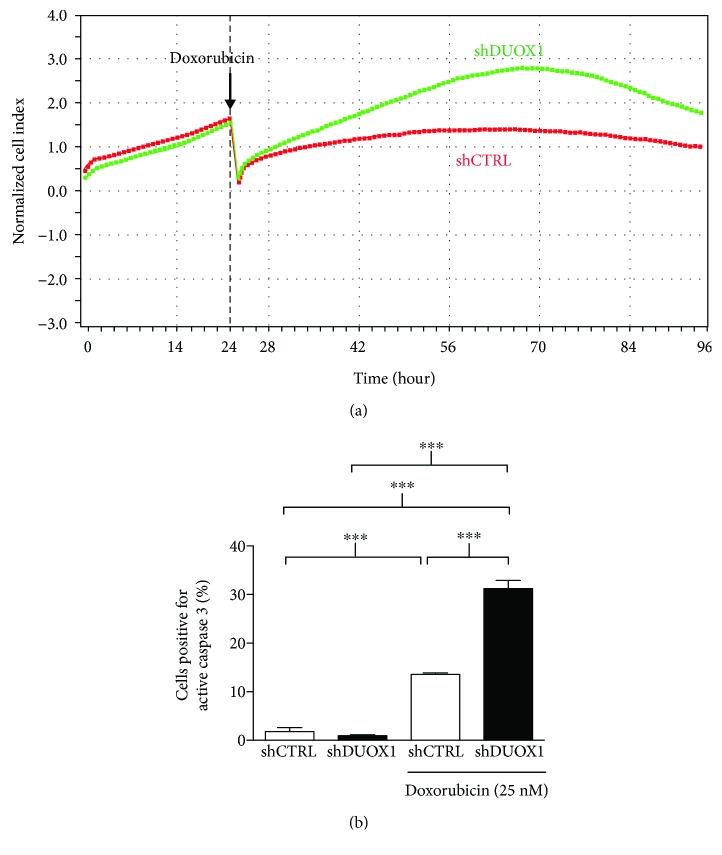
DUOX1 silencing alters genotoxic stress cellular responses. Real-time curves of cellular proliferation were obtained using the xCELLigence system for DUOX1-deficient (shDUOX1) and control (shCTRL) cells pretreated with 25 nM doxorubicin, for 24 h (arrows) (a). The active form of caspase 3 was quantified by flow cytometry, 48 h after doxorubicin treatment (b). Results are expressed as mean ± SEM of at least two independent experiments. ∗∗∗P < 0.001.